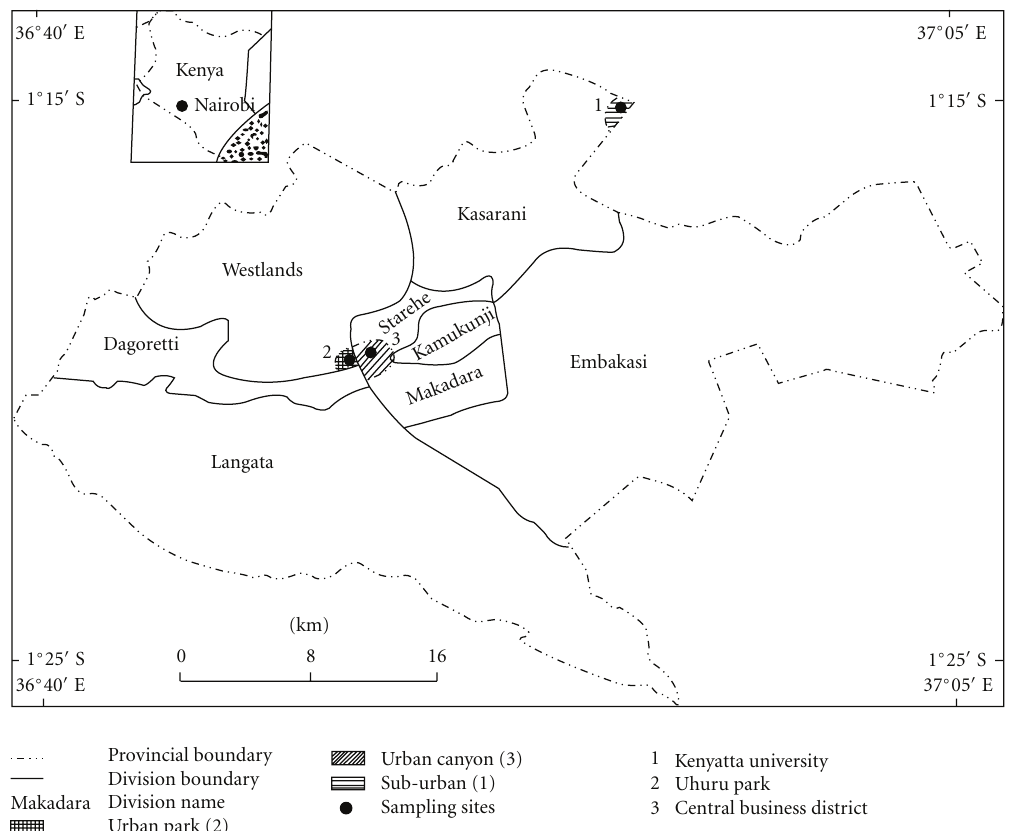
Figure 1: Study area showing the sampled